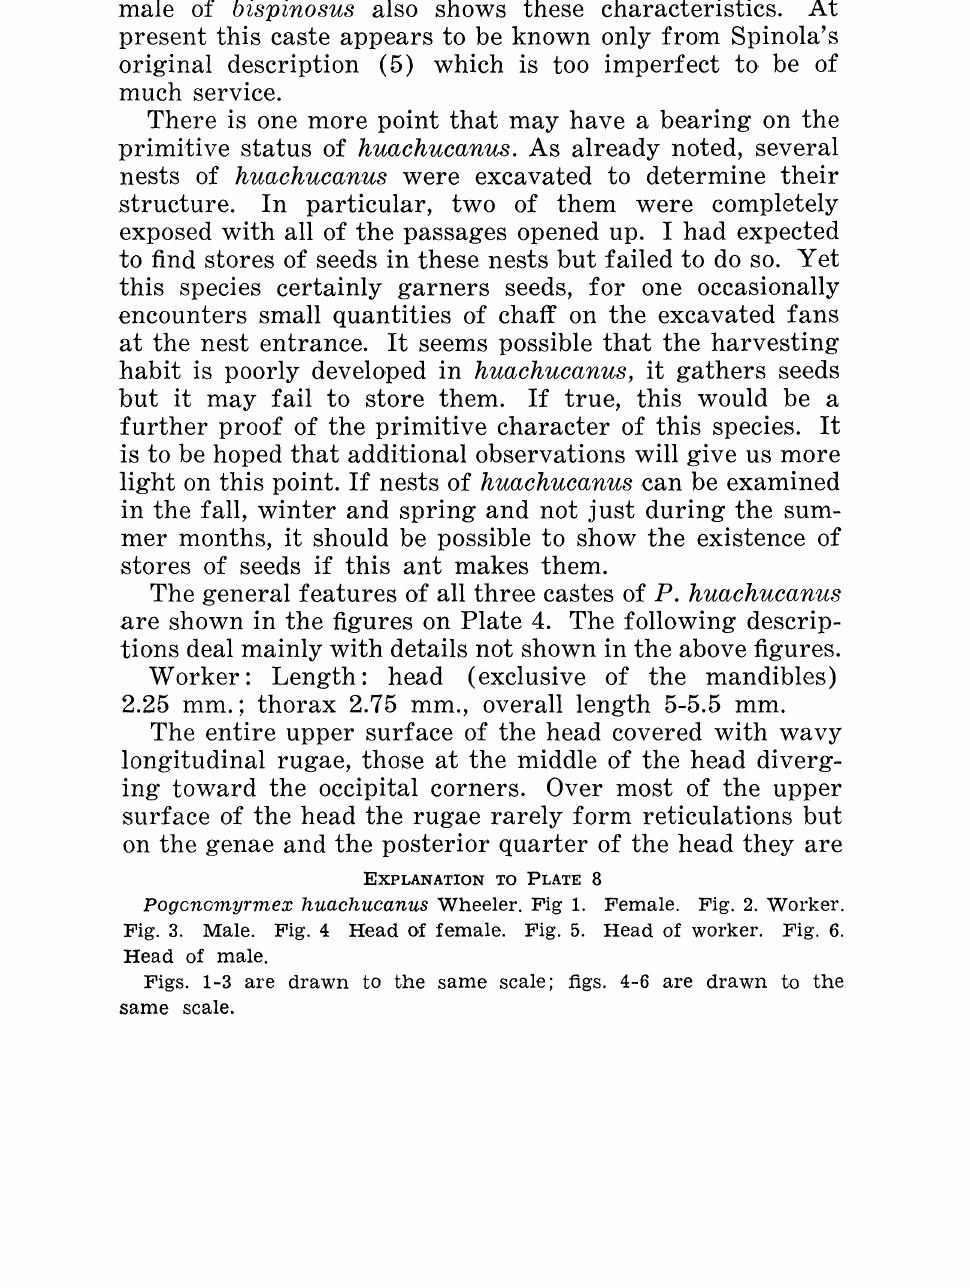
Fig. 3. Male. iig. 4 Head of female. Fig. 5. Head of worker. Fig. 6. Head of male. Figs. 1-3 are drawn to the same scale; figs. 4-6 are drawn to the same